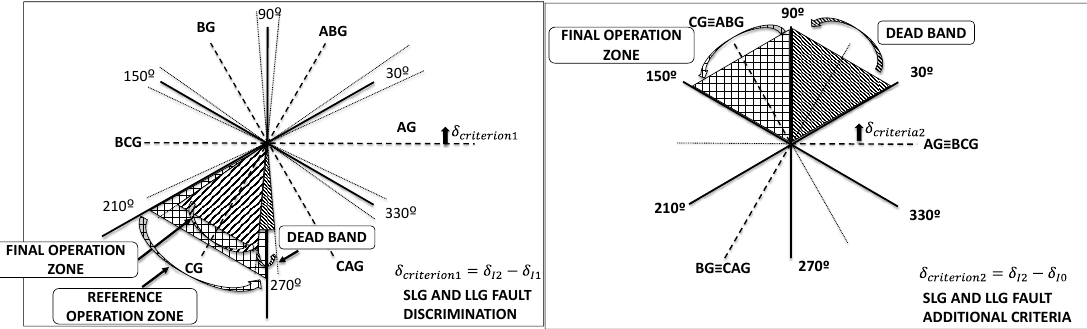
Figure 14. Application of Criterion 1 and Criterion 2 to CG faults.